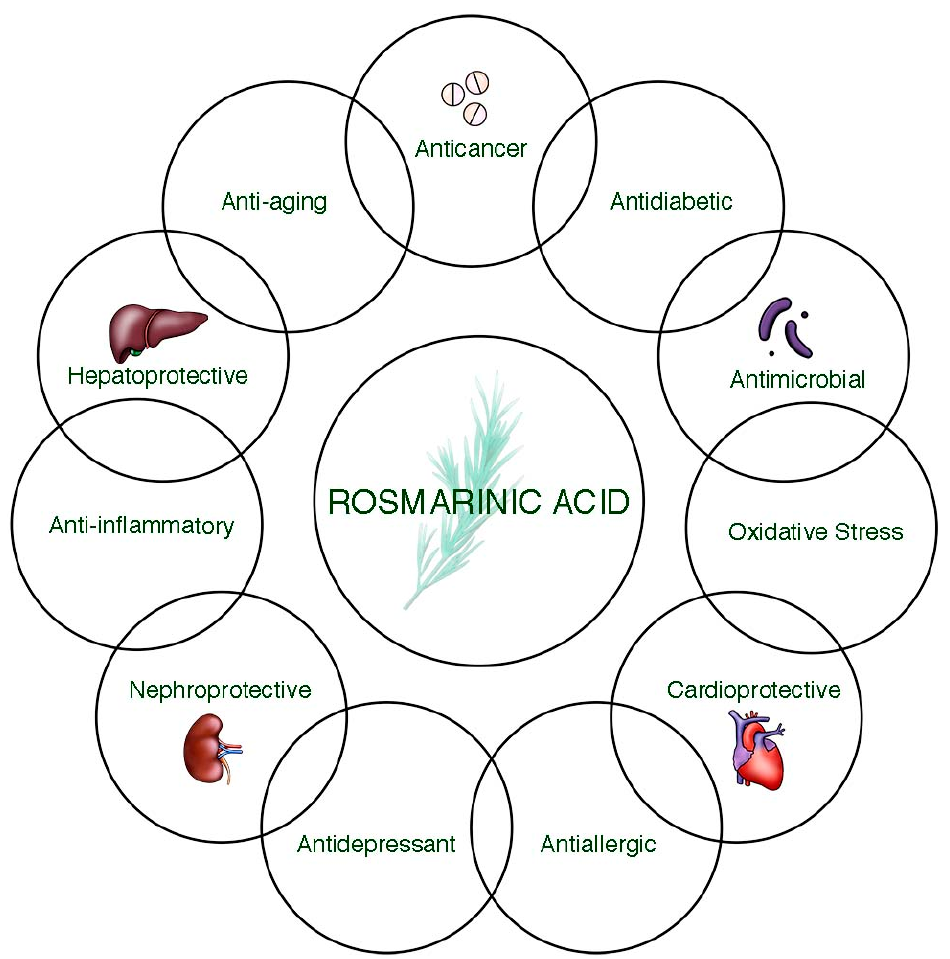
Figure 2. Rosmarinic acid and its potential functions.